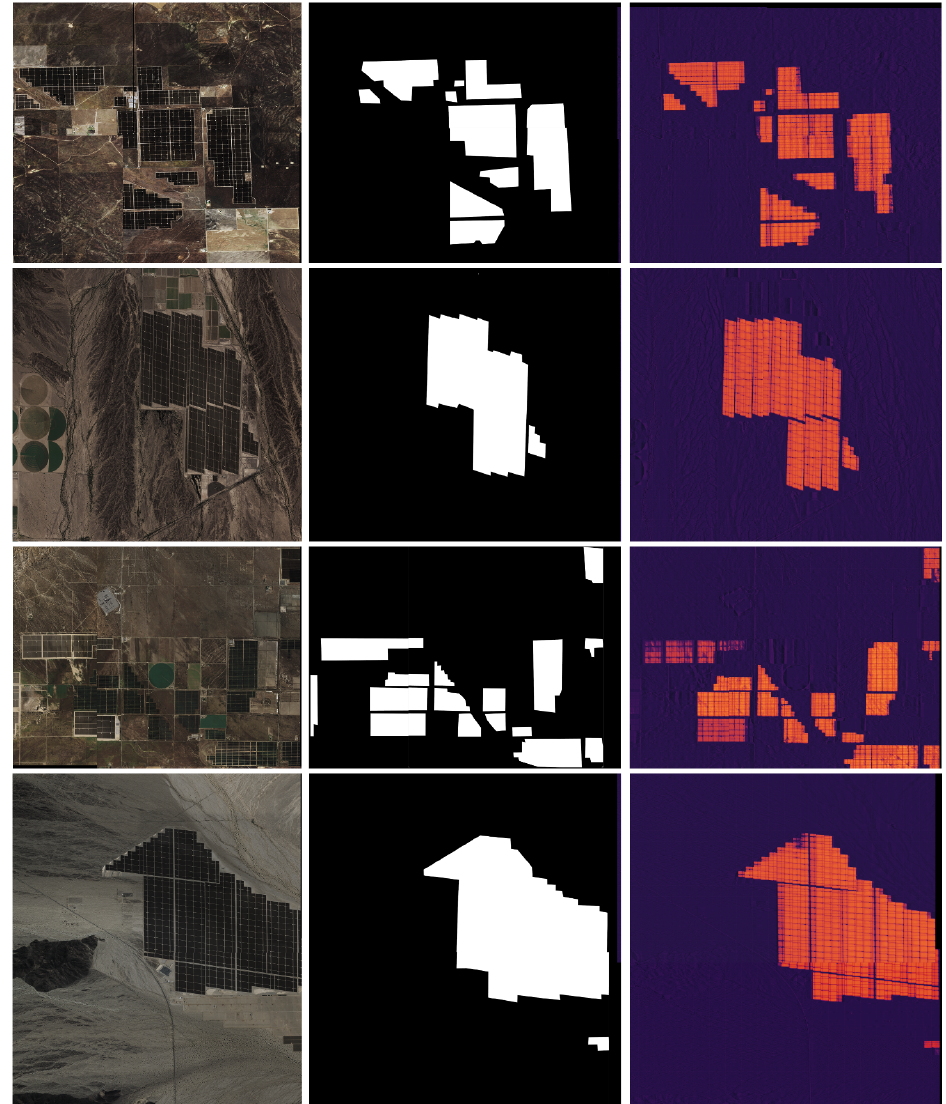
Figure 8. Segmentation performance on various test solar farms. Comparison of the confidence masks between teacher confidence (in black and white) and the student confidence (in color) shows that the model produces an output with better veracity than human